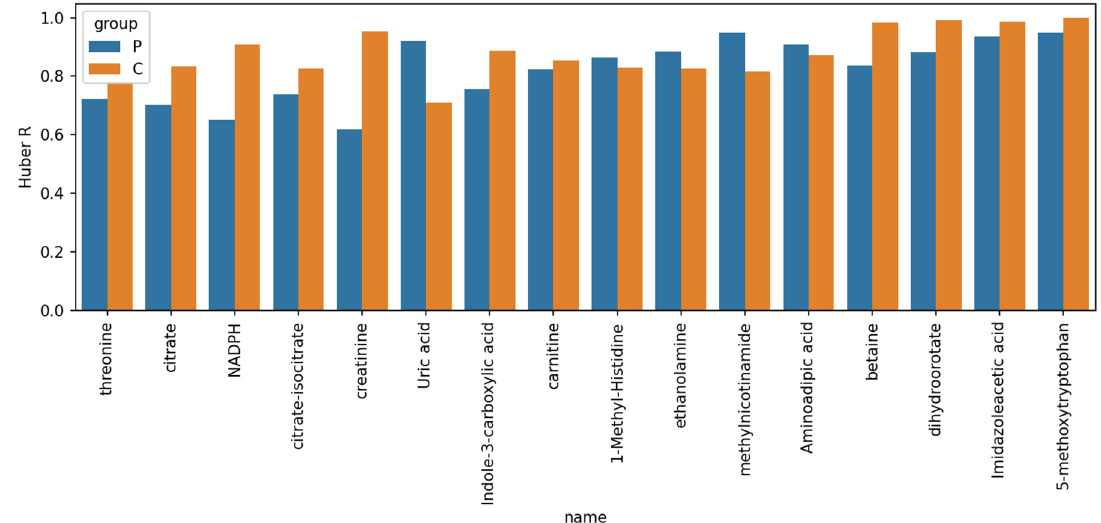
Figure 4. Coefficients of correlation of plasma and CSF metabolite profiles in the two separate groups: the group of patients (P) and control group (C).